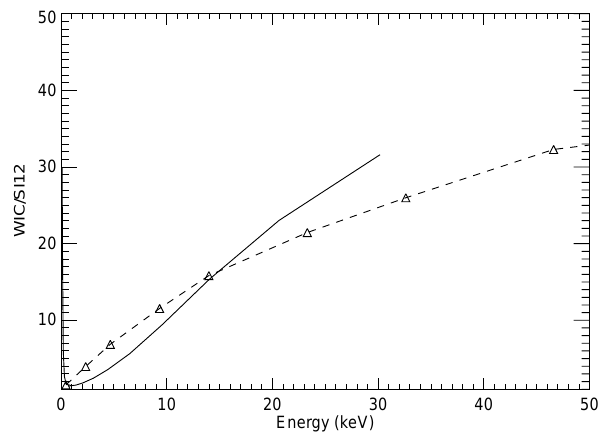
Fig. 4. Dependence of the WIC to SI12 count ratio on the mean proton energy (first efficiency curve). The solid line is for monoen- ergetic proton precipitation and the dashed line with triangles for a kappa-function distribution of the precipitating